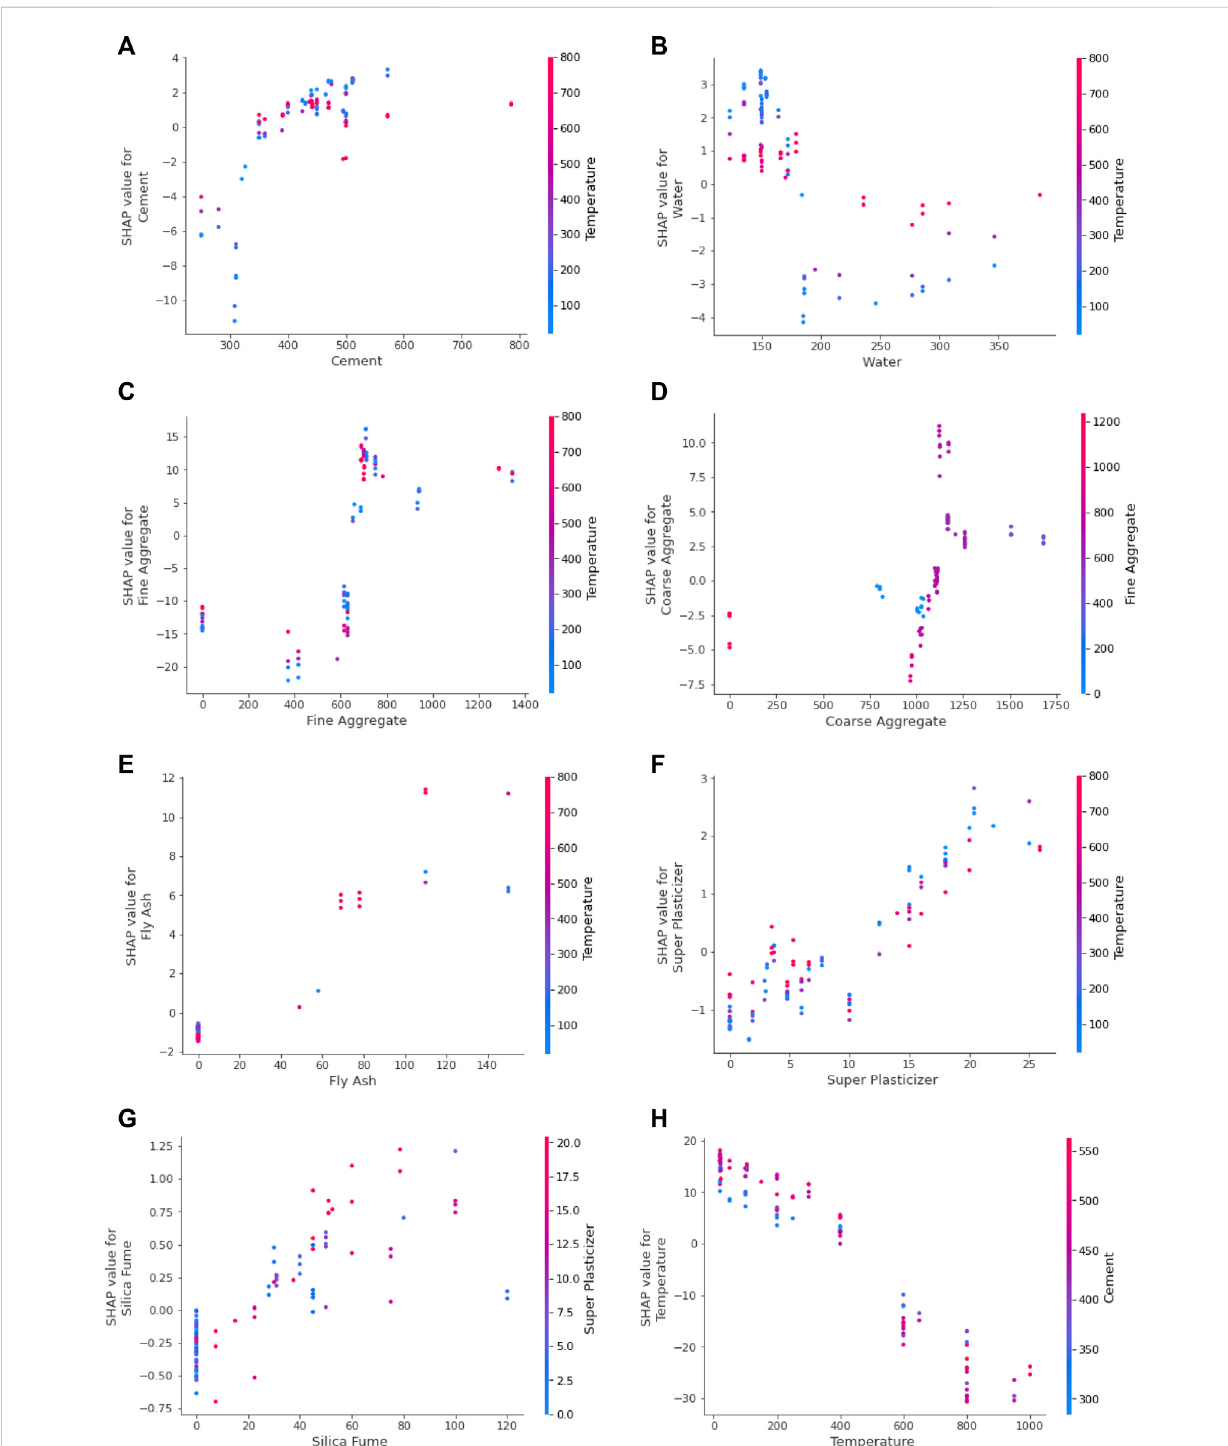
FIGURE 21 Feature interaction plot: (A) cement, (B) water, (C) fi ne aggregate, (D) coarse aggregate, (E) fl y ash, (F) super plasticizer, (G) silica fume, and (H) temperature.